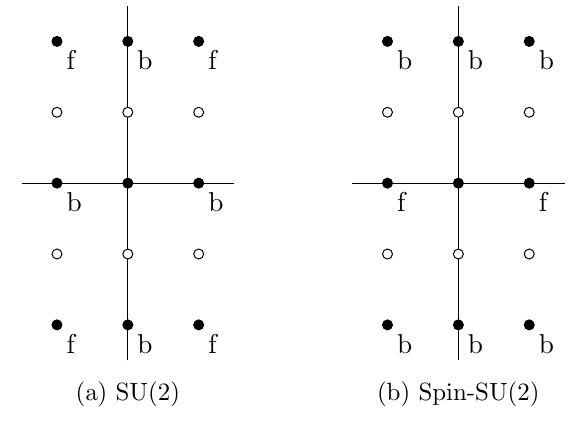
Figure 1. SU(2) lattices.